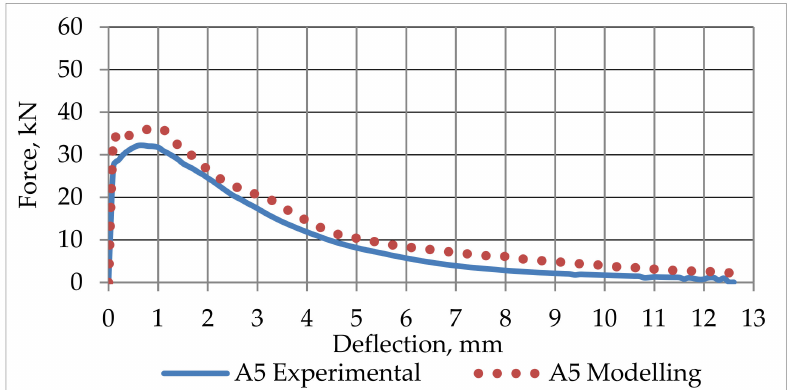
Figure 31. Experimental and modelling graphs for Group A5.